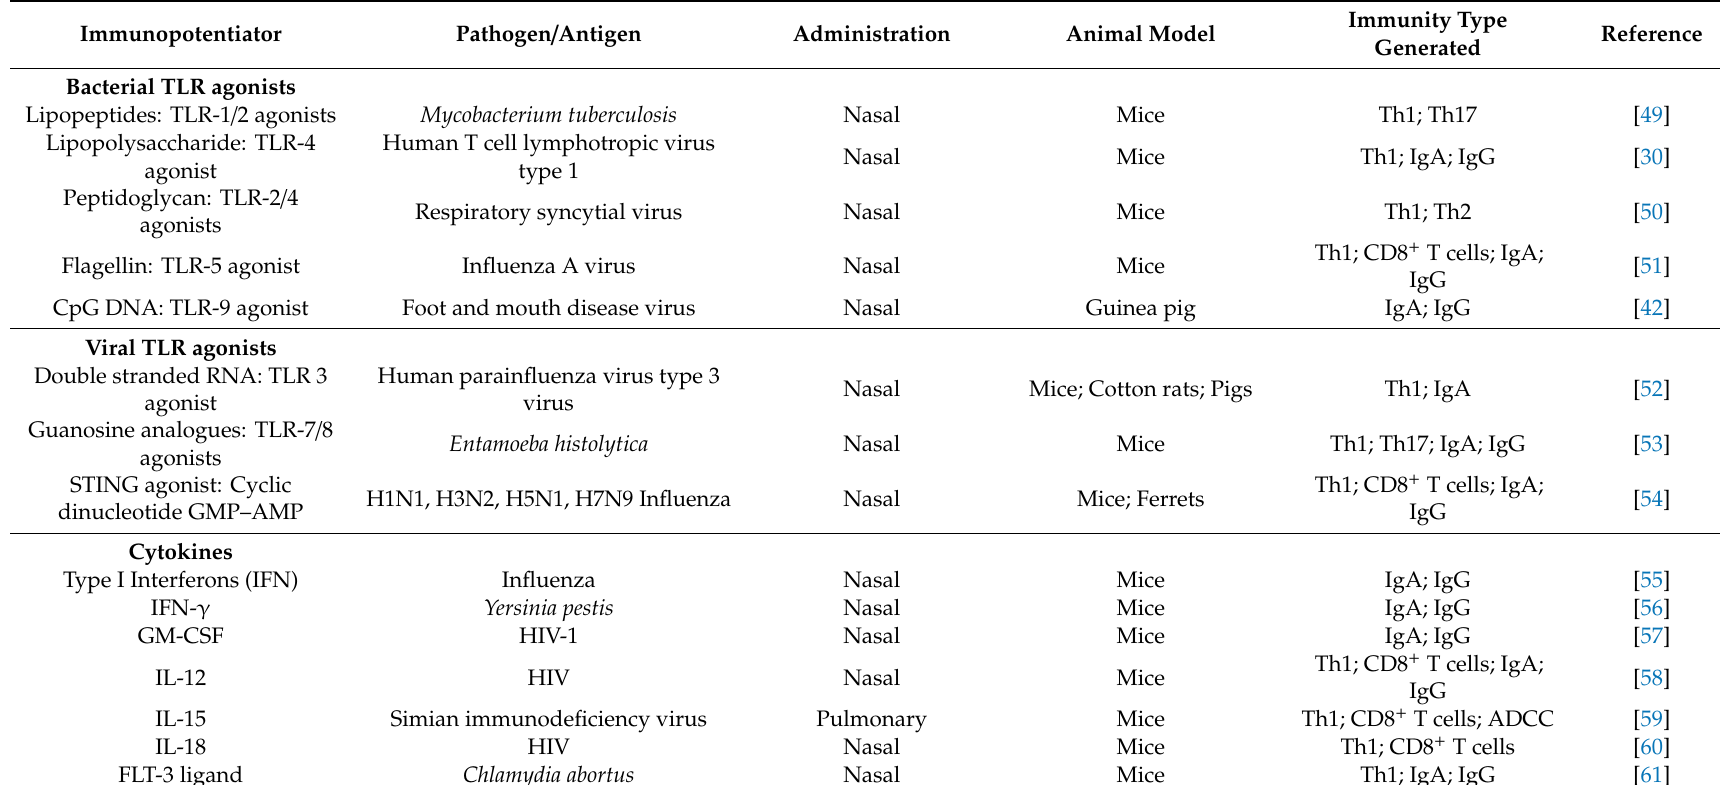
Table 3. Immunopotentiators for pulmonary and nasally delivered